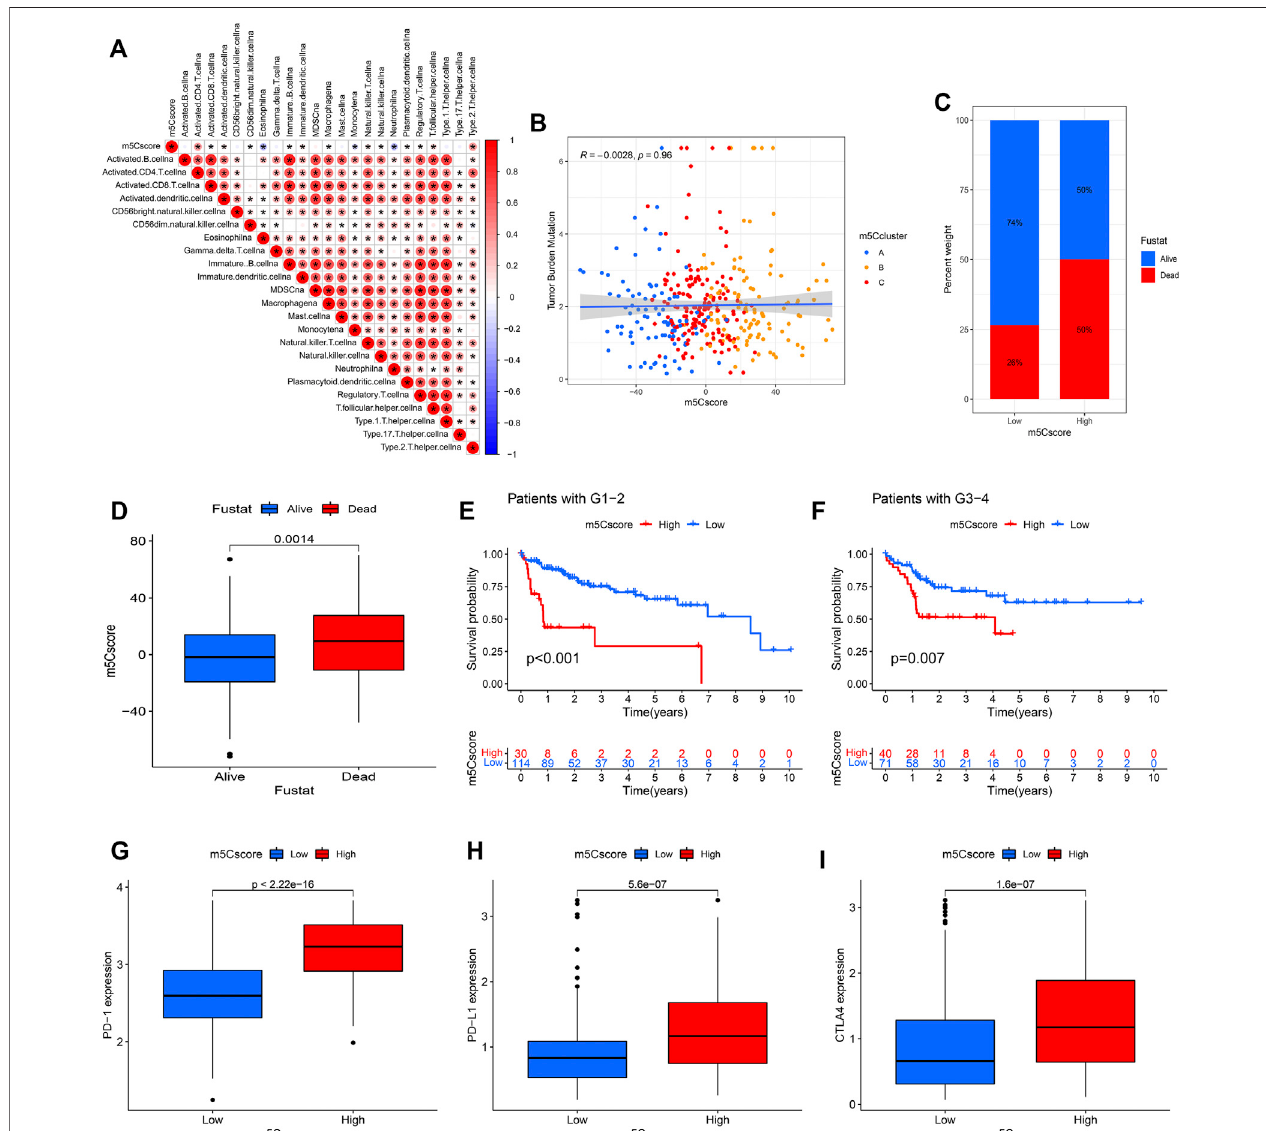
FIGURE8| Correlationanalysisbetweenthe m5Cscore and some related biologicalpathways. (A) Immunocorrelation analysis; (B) Tumormutation burden (TMB) correlation analysis; (C,D) Clinical correlation analysis; (E,F) Model validation in patients with different tumor grades; (G) PD-1 expression in distinct m5Cscore groups; (H) PD-L1 expression in distinct m5Cscore groups; (I) CTLA-4 expression in distinct m5Cscore groups.